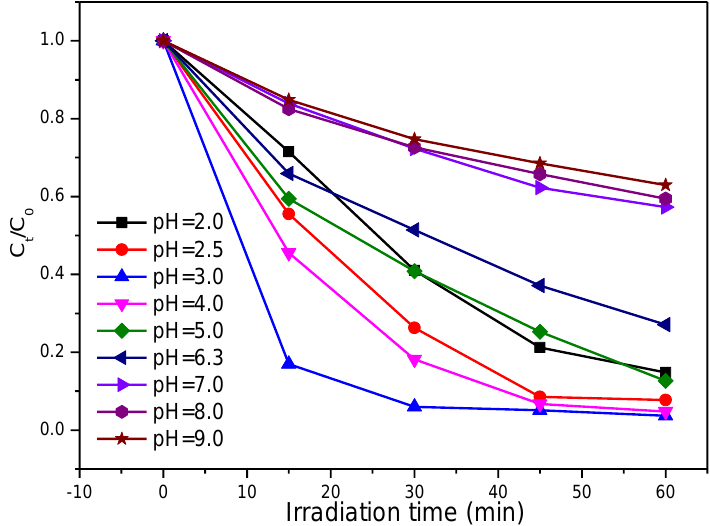
Figure 7. Photocatalytic reduction of Cr(VI) by Ga 2 O 3 at different initial pH.